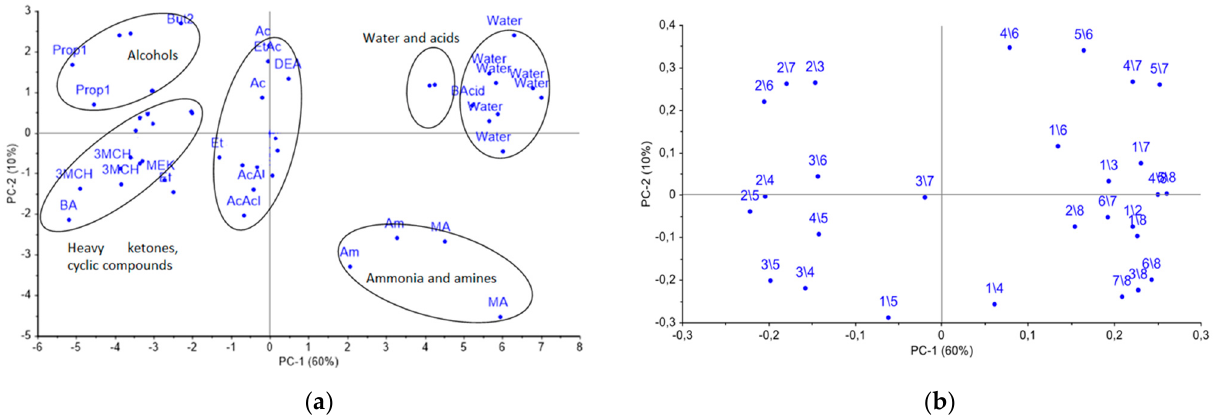
Figure 4. ( a ) PCA score plot for vapors of pure substances and ( b ) loadings obtained from the spectra of A(i/j) cross mass-sensitivity parameters. On the graph the variables are depicted as i/j, which means parameter A(i/j) , for instance, 2/3 = A(2/3).